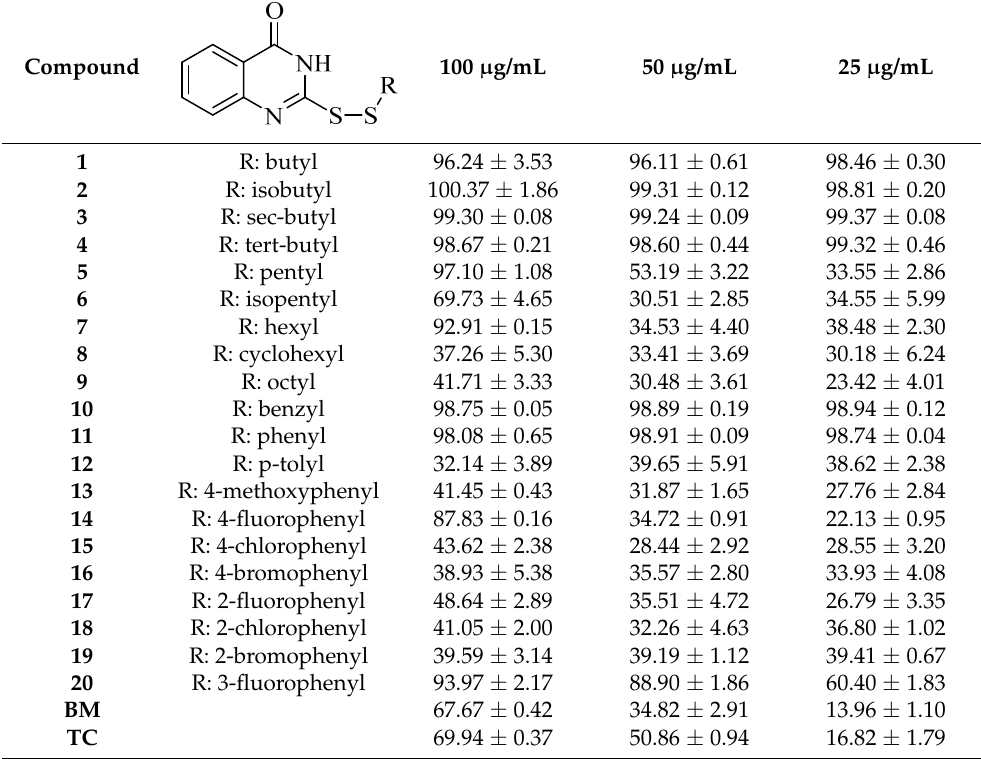
Table 1. Inhibition rate (%) of the target compounds against Xanthomonas axonopodis pv. citri at 100, 50, and 25 µ g/mL.